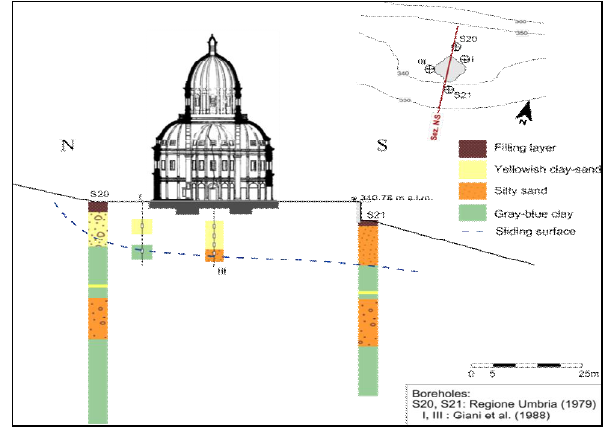
Figure 15. Soil profile from previous in-situ investigation. As a first attempt to capture the measured rotation  along the main axis (   0.5°), which is consistent with the total settlement (w = 0.375 m) measured at the north side, along the direction N-S, the rotational stiffness of the soil-foundation system has been introduced (K  , Tab. 3). Although the